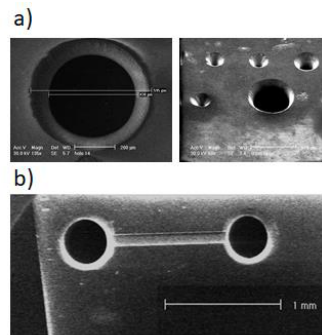
Fig. 4. (a) SEM images of through-holes in diamond (b) lab-on- chip prototype for microfluidics